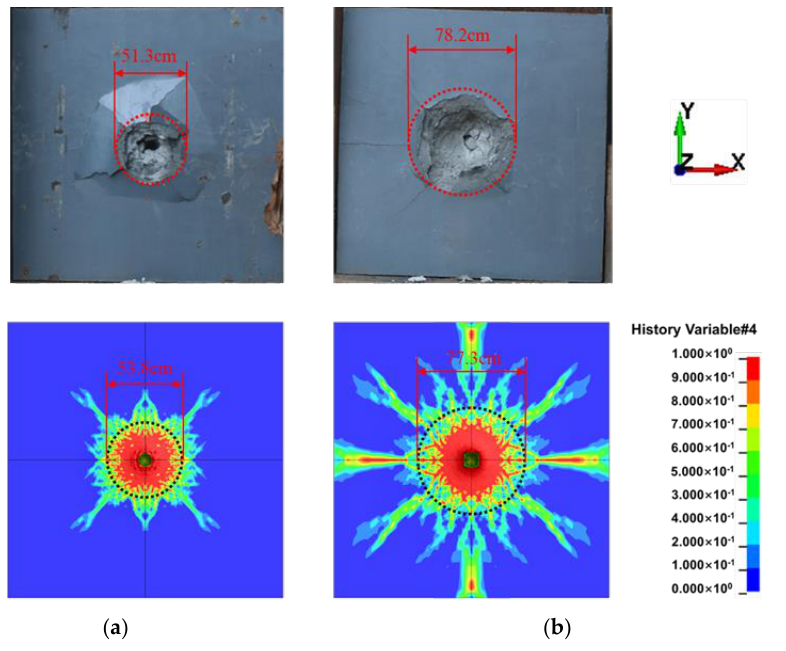
Figure 16. Comparison of frontal damage between the experimental and numerical results; ( a ) U-1, 410 m/s; ( b ) U-2, 664 m/s.